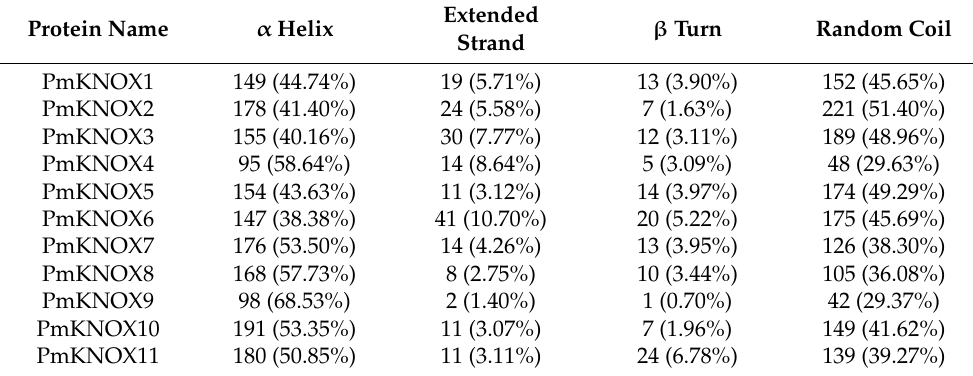
Table 2. Analysis of the secondary structure of PmKNOX